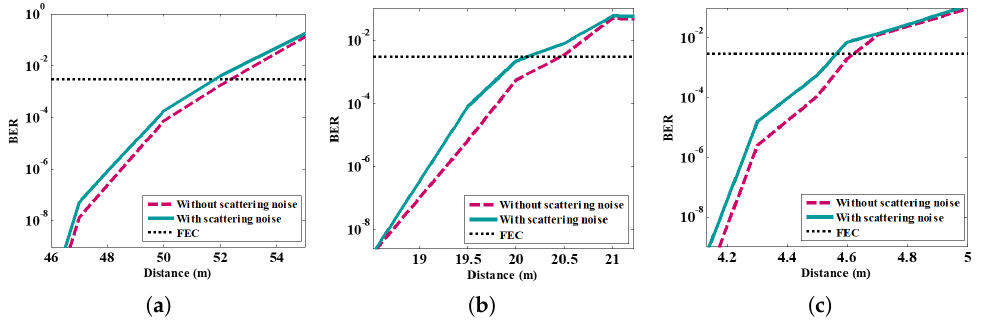
Figure 4. The BER performance against the link distance: ( a ) clear, ( b ) coastal, and ( c ) harbor.